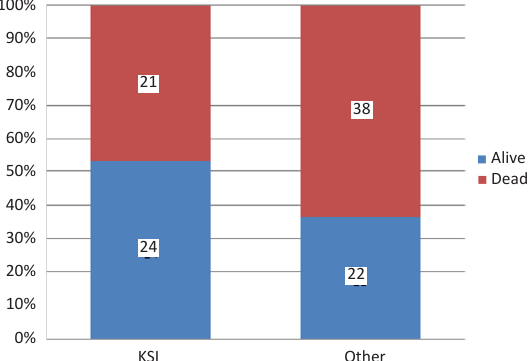
Figure 6. Survivorship of vultures comparing kite string injuries and other causes for